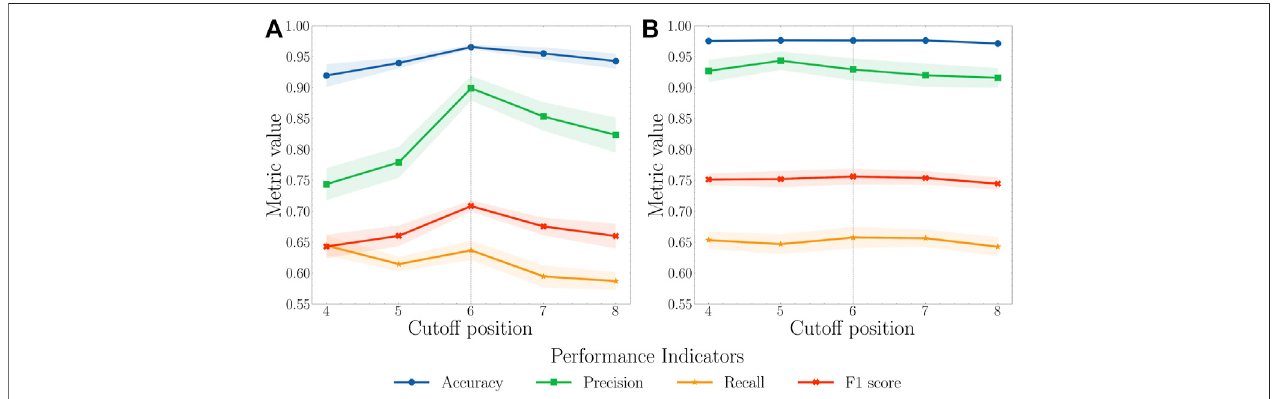
FIGURE3|(A) AutoKeras and (B) AutoGluon modelsperformanceforallpocketsoftheproteinsinthevalidation set basedon differentcutoffpositions.Thecutoff value for the training set ranges from 4 to 8. Each model was trained in 10 independent runs for each value. The mean and standard deviation of each metric were calculated. A cutoff of 6 was considered reaching a balance between recall and precision with the highest F1 score.